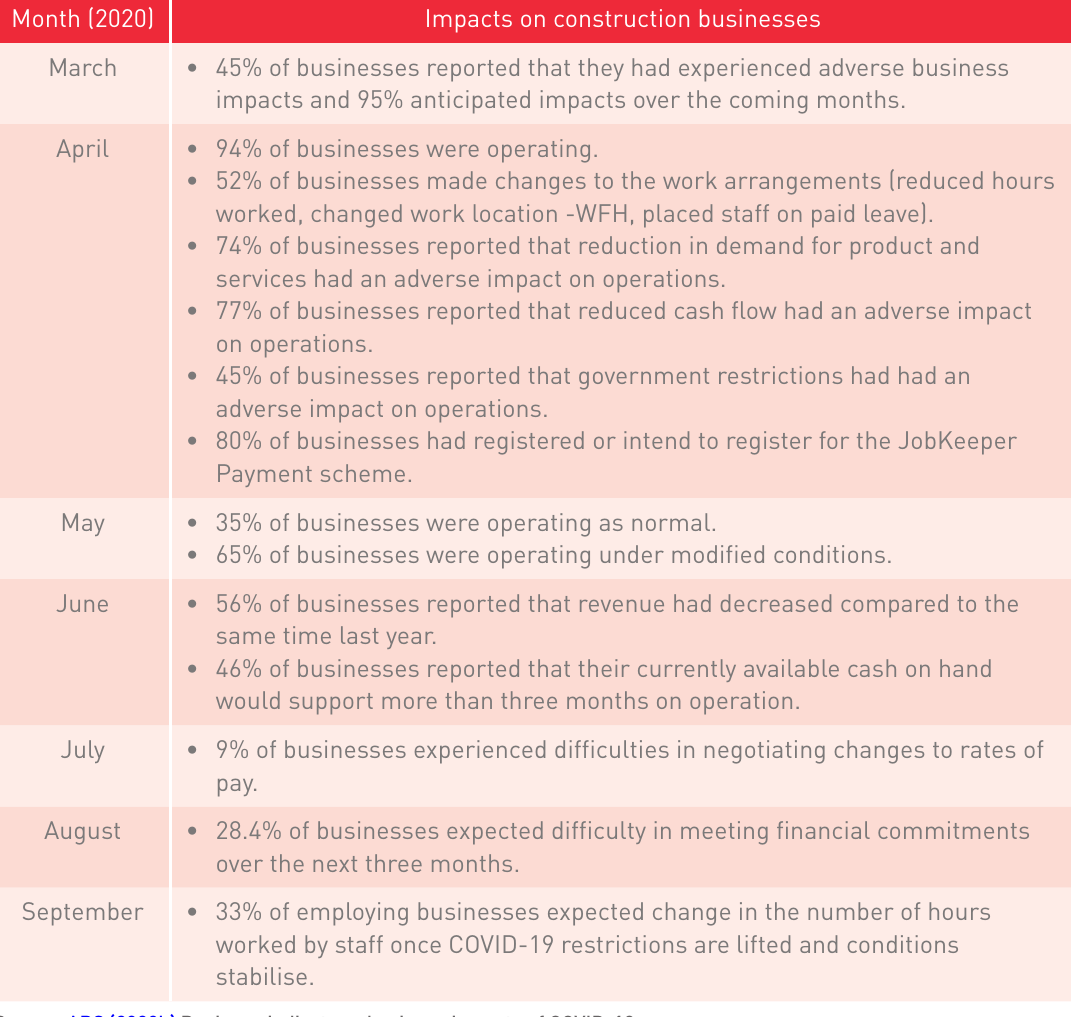
The impacts of the COVID-19 pandemic on construction